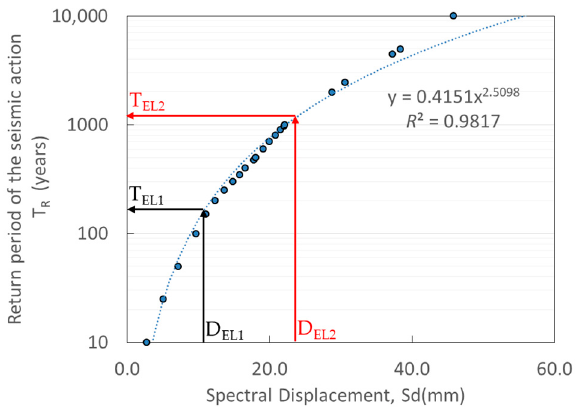
Figure 8. Structural response hazard curve—graphical representation of the procedure for calculating the return periods associated with the exceedance of the structural response limit states EL1 and EL2.